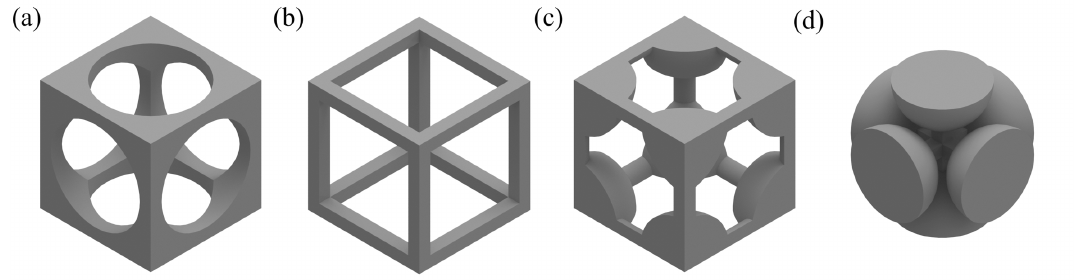
Figure 1. Exemplary cubic unit cell geometries, with ( a ) three cylindrical holes; ( b ) quadratic scaffold; and ( c ) corner balls connected by circular cylindrical beams, as taken from our